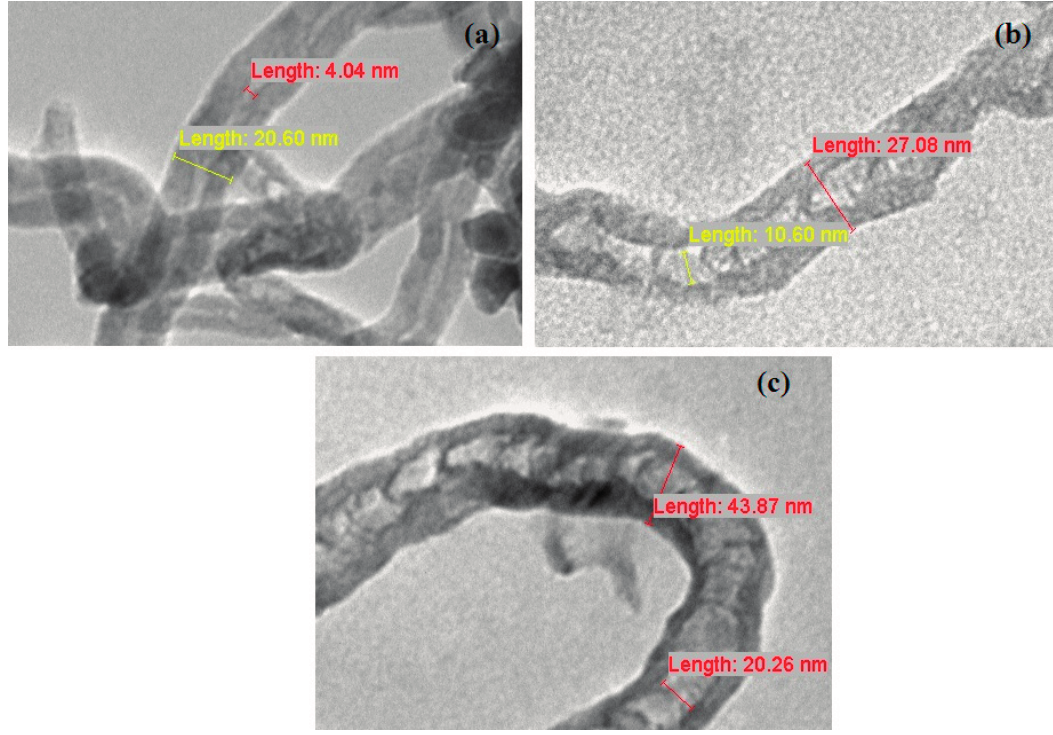
Figure 6. Transmission Electron Microscope (TEM) images of carbon nanotubes of CoNiAl-CNT ( a ); FeNiAl-CNT ( b ) and FeCoNiAl-CNT ( c